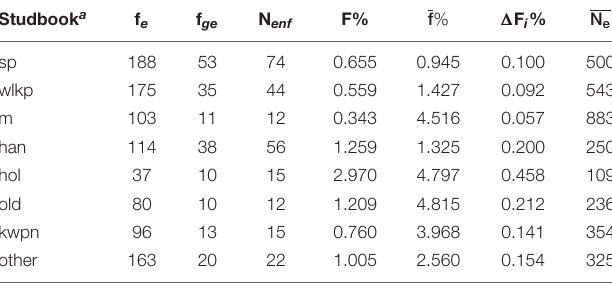
TABLE 6 | Effective number of founders (f e ), founder genome equivalent (f ge ), effective number of non-founders (N enf ), average inbreeding coefficients (F%), average coancestry (f%),average individual increase in inbreeding ( (cid:49) F i %), and effective population size (N e ) for the groups by studbook.